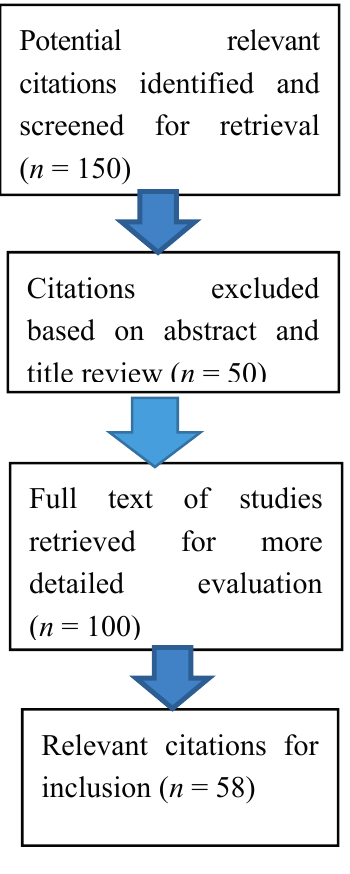
Figure 1. Results of the literature